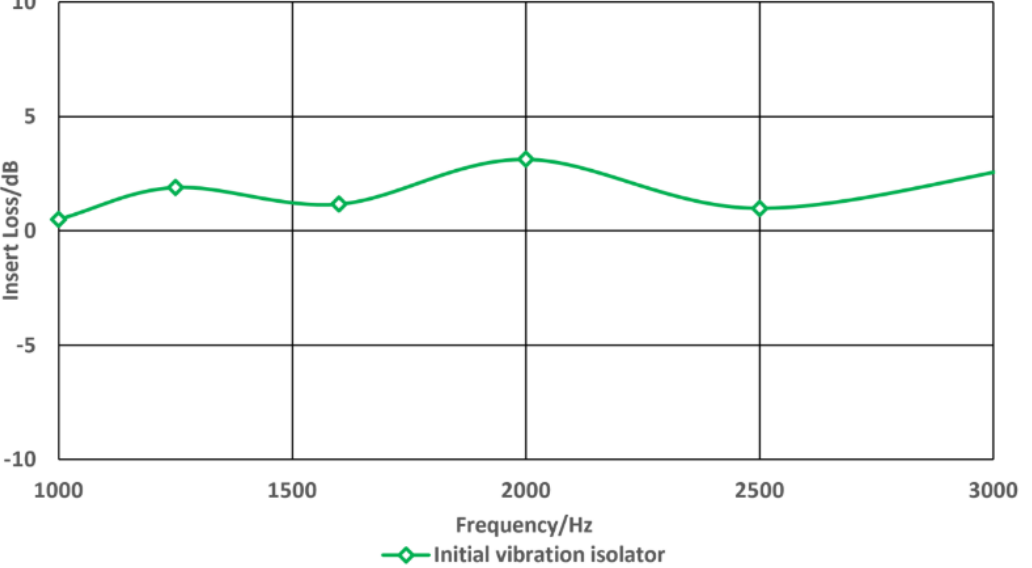
Figure 5. Insertion loss test results of initial isolator.